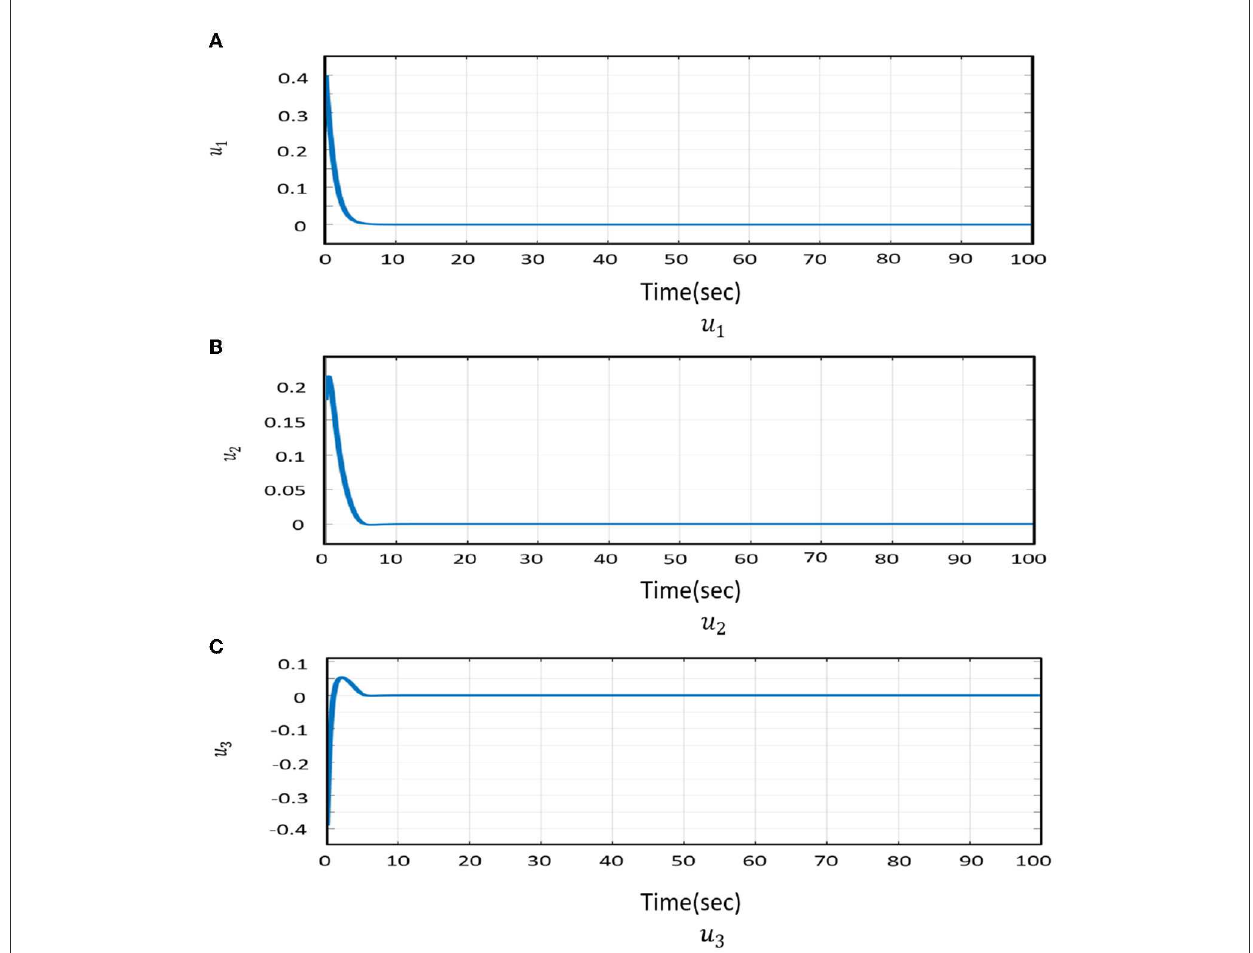
FIGURE8 The dynamical change of the synchronized states of control effort u i . (A) u 1 , (B) u 2 , and (C) u 3 .